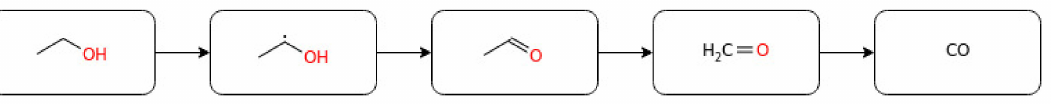
Figure 6. A simplified reaction pathway for ethanol